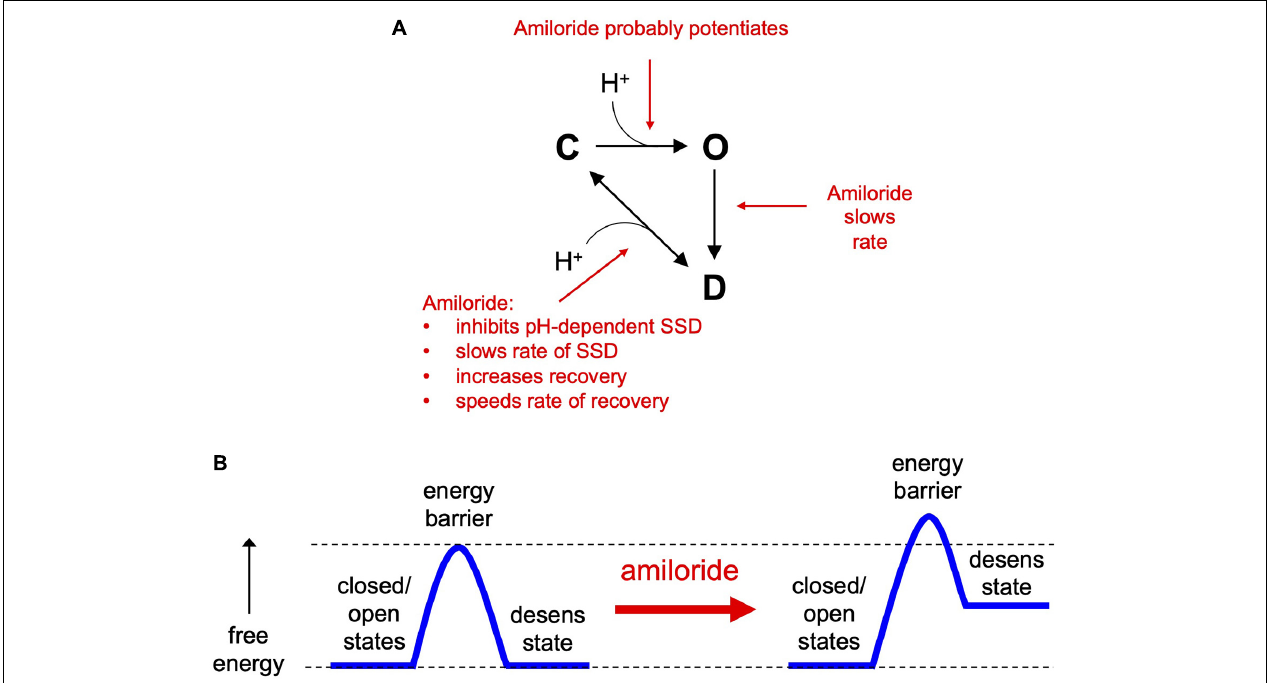
FIGURE 10 | The effects of amiloride on ASIC3 gating properties. (A) A simple state model highlighting the various effects of amiloride on ASIC3 gating [closed (C), open (O), and desensitized (D) states]. (B) An energy barrier model demonstrating how amiloride increases the barrier to the desensitized state and increases the free energy of the desensitized